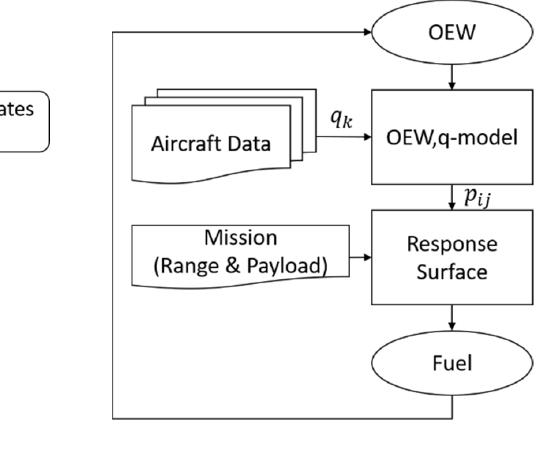
Figure 5. Preliminary design cycles with the Breguet range equation (Equation (5)) and the OEW,q- model (Equation (6) and (7)).